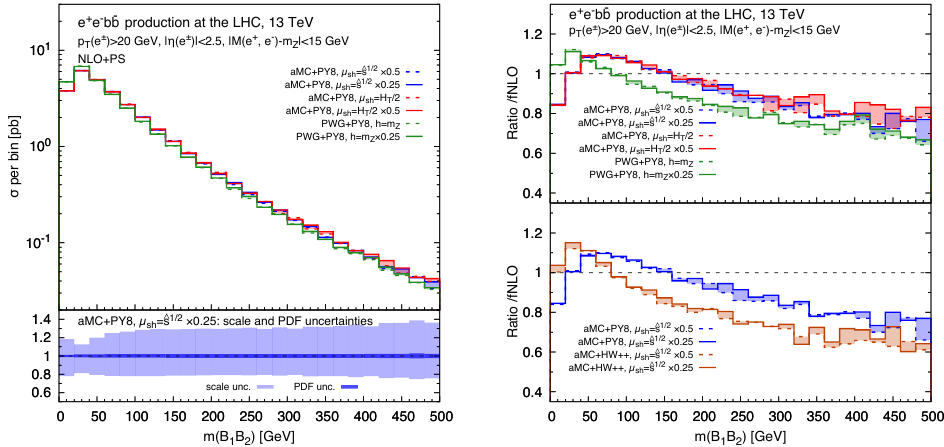
Figure 20 . Invariant mass distribution of the B hadrons pair in association with at least 0 b jets.